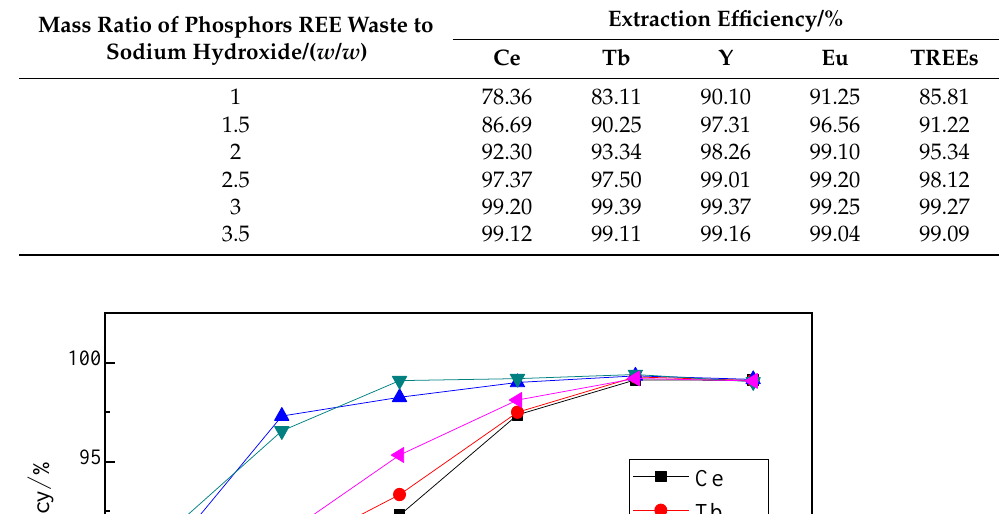
Table 5. Extraction efficiency of Ce, Tb, Y, Eu, and total rare earth under different mass ratio of